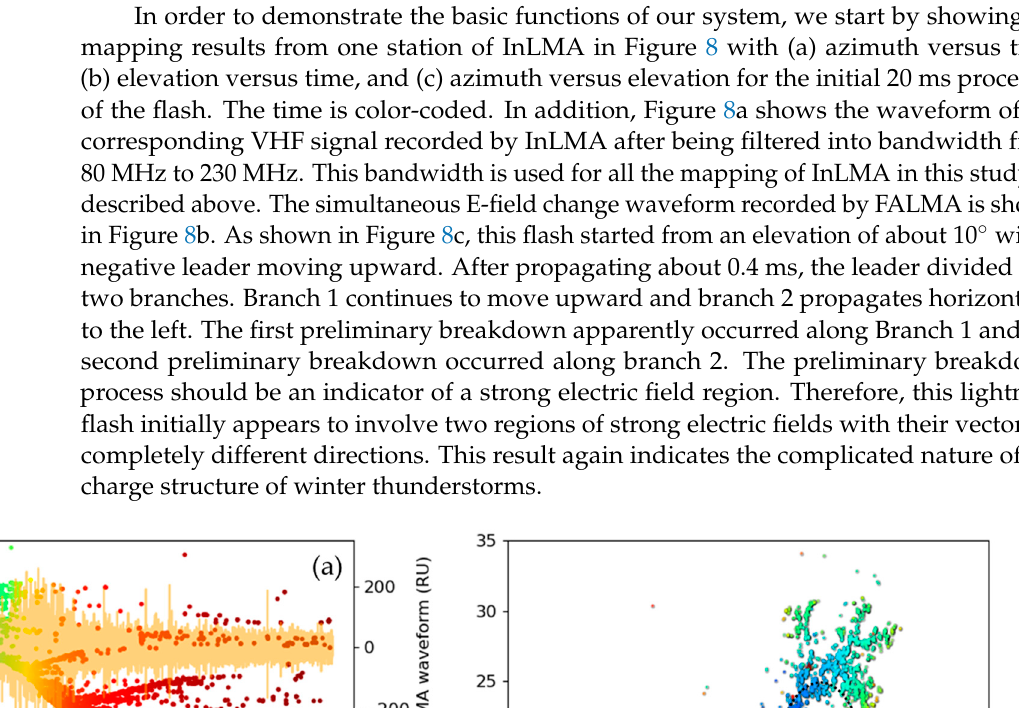
Figure 7. Example waveform and frequency spectrum of the raw lightning data recorded at one channel of InLMA. ( a ) Signal waveform and background noise; ( b , d , f ) Frequency spectrum of the fl ash signal; ( c , e , g ) Frequency spectrum of the noise.